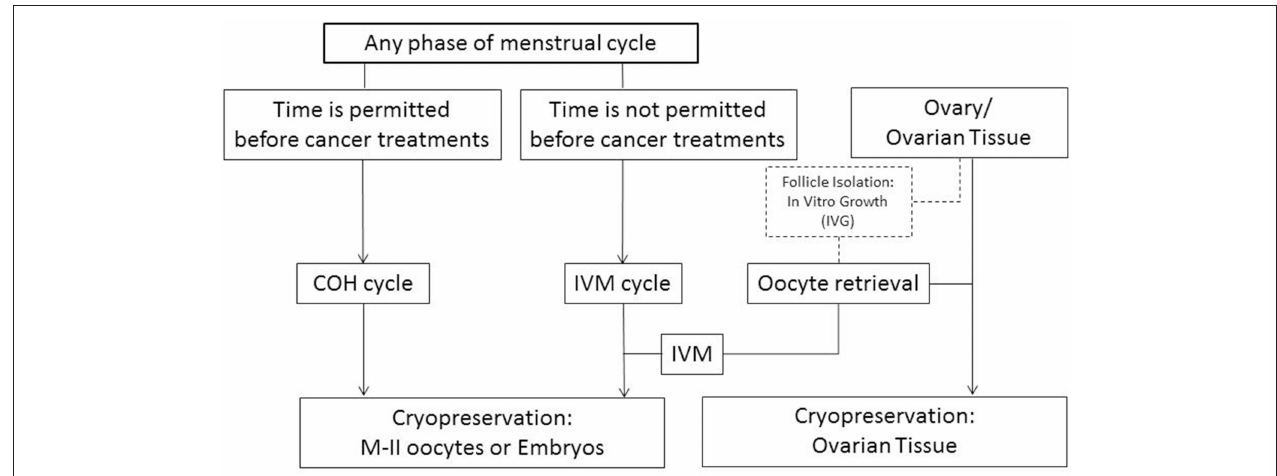
FIGURE 1 | Fertility preservation strategies for female cancer patients depending on their clinical situations. COH, controlled ovarian hyperstimulation; IVM, in vitro maturation. Discontinuous lines/box: experimental